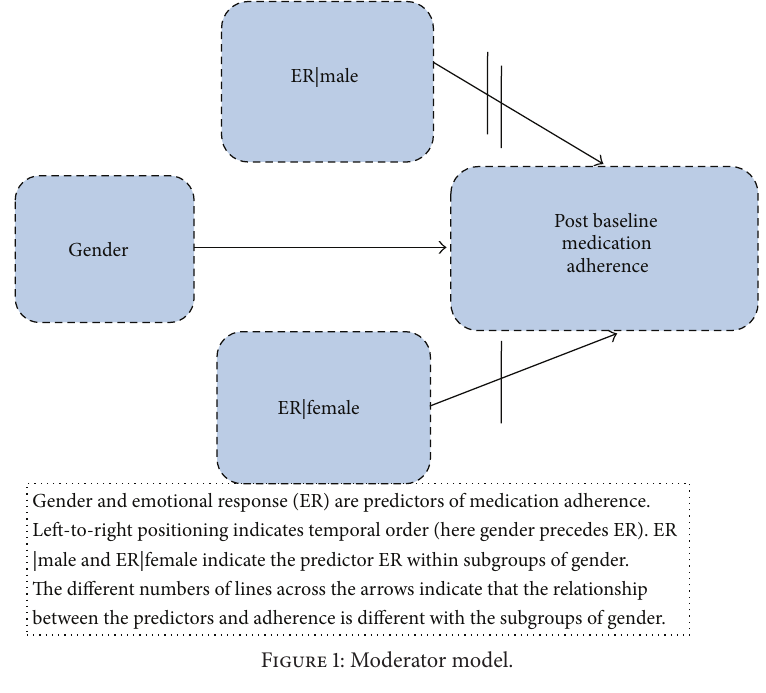
Figure 1: Moderator